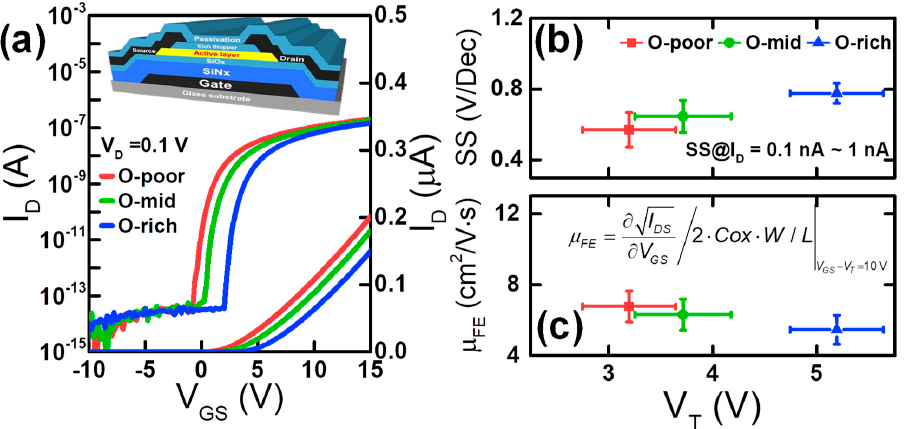
Figure 2. ( a ) I D – V GS transfer curve characteristic at V DS = 0.1 V for various O-contents. The inset is the fabricated a-IGZO thin-film transistor (TFT) with an inverted staggered bottom-gate structure. The statistical data of ( b ) subthreshold swing (SS)-V T , and ( c ) μ FE- V T were extracted from 10 devices for each O-content.